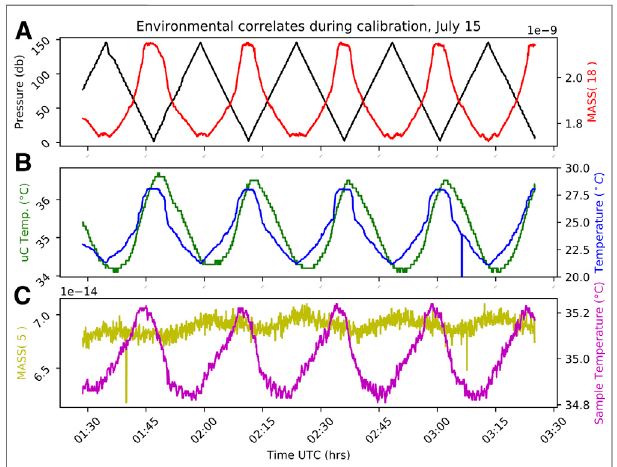
FIGURE 4 | Time series of environmental correlates used to bias correct thepCO 2 signalmeasuredbyshipboardQMSatm/z (cid:3) 44(panels (C) and (F) ). Panels (A) and (D) show the lab temperature and QMS vacuum pressure; panels (B) and (E) show water vapor (m/z (cid:3) 18) and m/z (cid:3) 15. Panels (D), (E), and (F) show the time series for one 12 h period on June 1, 2017.